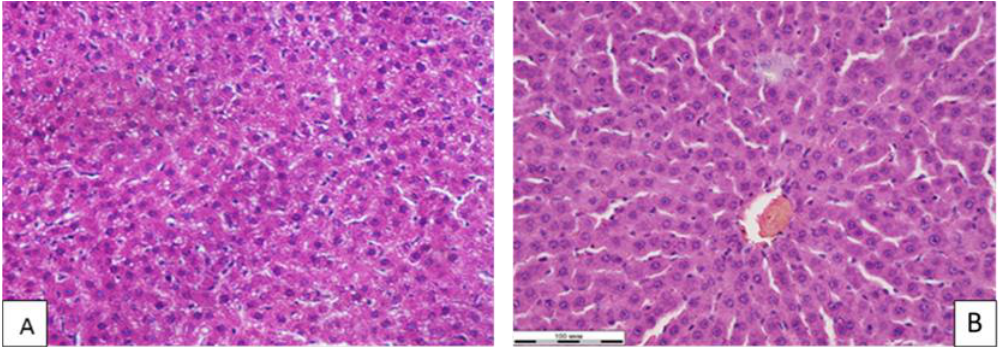
Figure 4. Microphoto of liver tissue of white rats of experimental ( A ) and control ( B ) groups. okr. Hematoxylin – eosin. Mag. ×400.